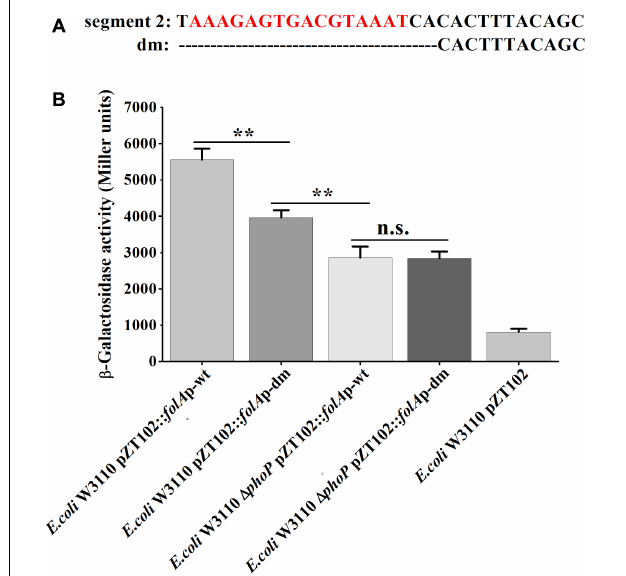
FIGURE 6 | Determination of the PhoP-binding sites in the promoter of folA . (A) The deletion mutant was designed in segment 2 of the promotor region of folA , designated as dm. The predicted putative “reverse PhoP box” is indicated with red letters. (B) β -Galactosidase activities were measured from exponential phase aerated cultures in LB of the wild-type E. coli W3110 strain and (cid:49) phoP mutant strain. They either carry the pZT102 reporter plasmids containing the promotor region of folA (–165/+26) or its mutants (dm). Data represent mean ± SD from three independent experiments. P values were